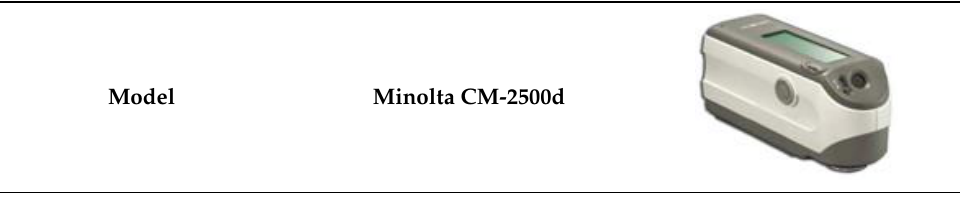
Table 1. Specifications of the spectrophotometer (Minolta CM-2500d).